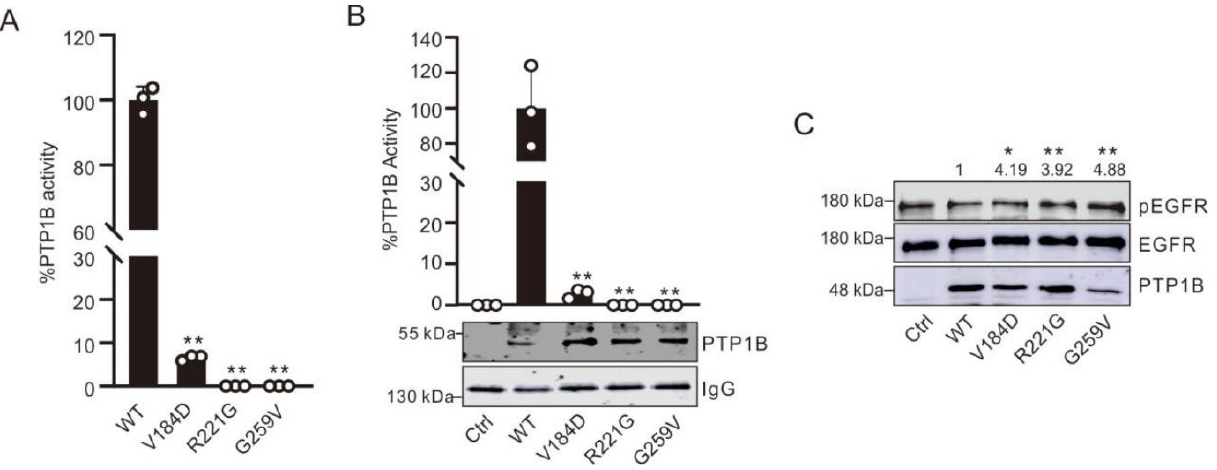
Figure 2. In vitro and in cellulo determination of the PTP1B activity in the WT and mutants. ( A ) PTP1B enzyme (5 nM) activity in the WT or mutants was assessed by RP-UFLC using a pSTAT1 fluorescent peptide. Data are presented as the mean of three independent experiments ± SD. ** p -value < 0.01 (compared to WT PTP1B). ( B ) HEK 293T cells transfected with the WT’s or mutants’